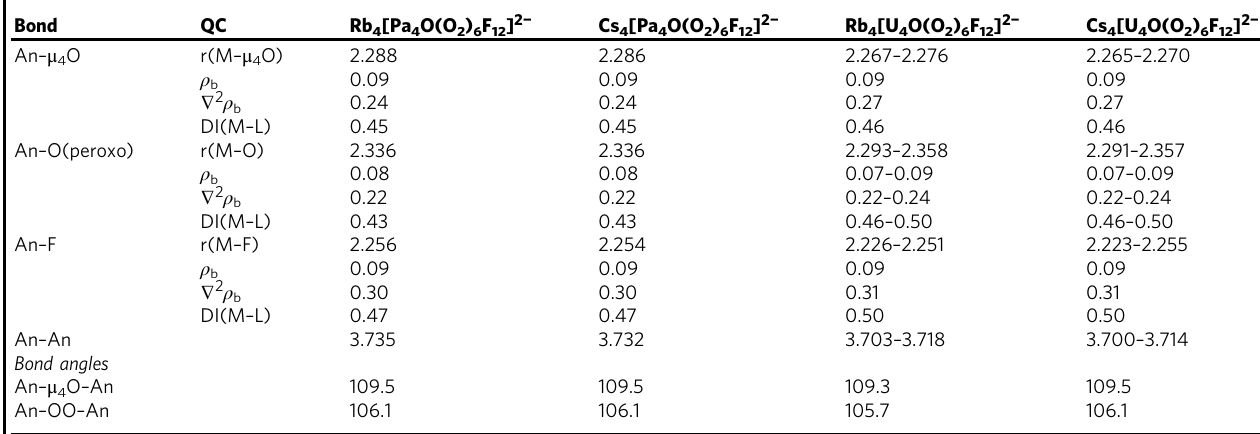
Table 2 Average bond distances and QTAIM characteristics of the bond critical points in Rb 4 [An 4 O(O 2 ) 6 F 12 ] 2 – and Cs 4 [An 4 O (O 2 ) 6 F 12 ] 2 – (An = Pa(V),